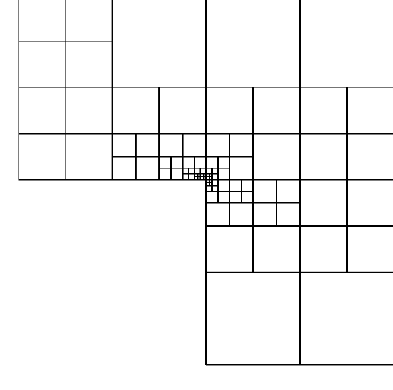
Figure 20. Distribution of effective gradient.